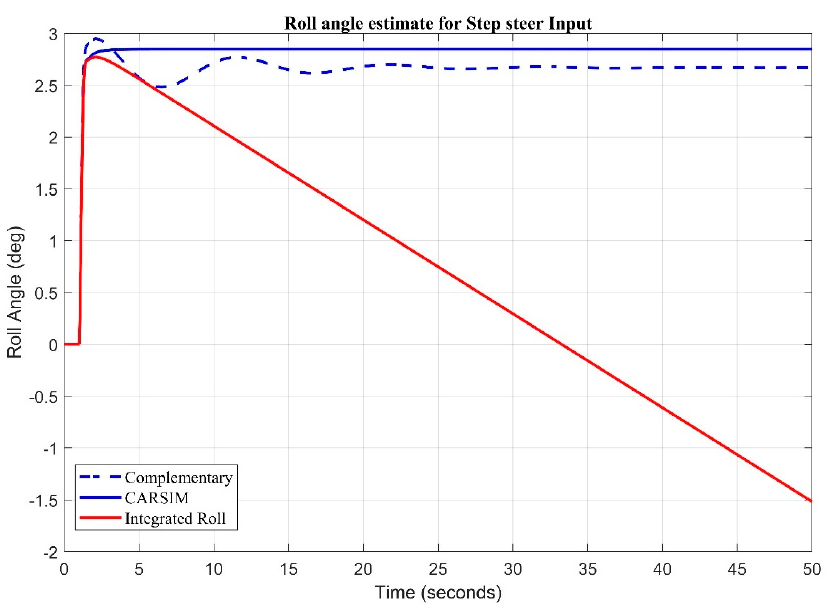
Figure 16. Complementary Filter Response for Step Steer Input.